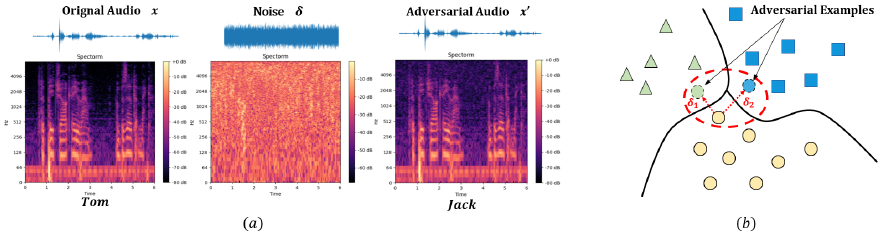
Figure 3. A sample of adversarial example generated from inserting a perturbation δ into a legiti- mate audio x on a 2D space. Figure ( a ) shows the waveform and mel-spectrogram of the original audio, noise and adversarial audio. Figure ( b ) denotes the presentation of dyadic samples on the data distribution.